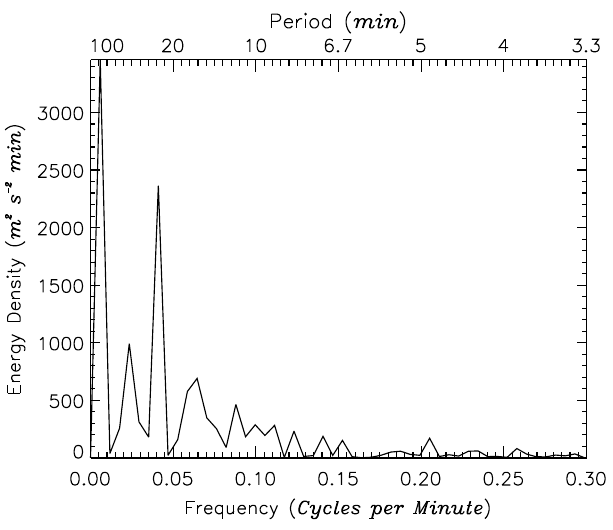
Fig. 4. Power spectrum of LOS Doppler velocities recorded at range cell 36 (1800km) on TIGER beam 4 during 12:15 to 15:00UT, 10 December 1999. Isolated Doppler velocity spikes further than 3 standard deviations from the mean were suppressed to remove high-frequency noise from the power